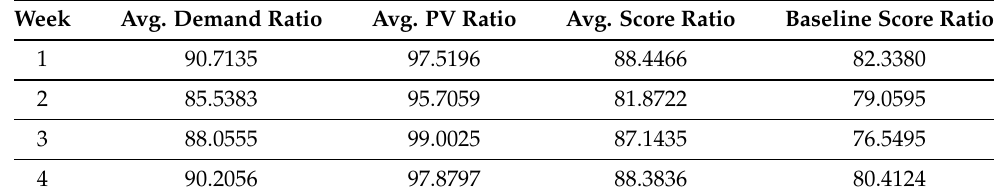
Table 4. Scores obtained for each of the four weeks, expressed as a percentage of the optimal solution and disaggregated into demand- and PV power-related factors. For reference, the corresponding score obtained by copying the previous week demand and PV power are